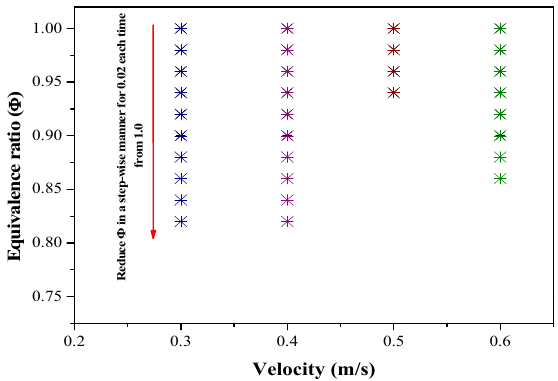
Figure 7. The flame extinction limit with different velocities.